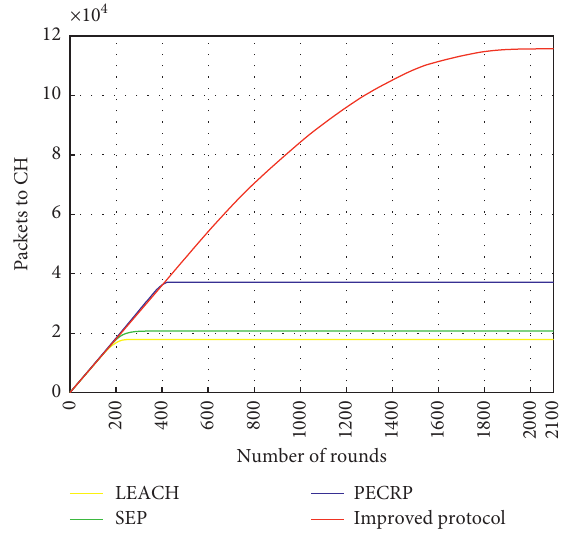
Figure 13: Comparison of packets sent to CHs from member nodes without power supply.